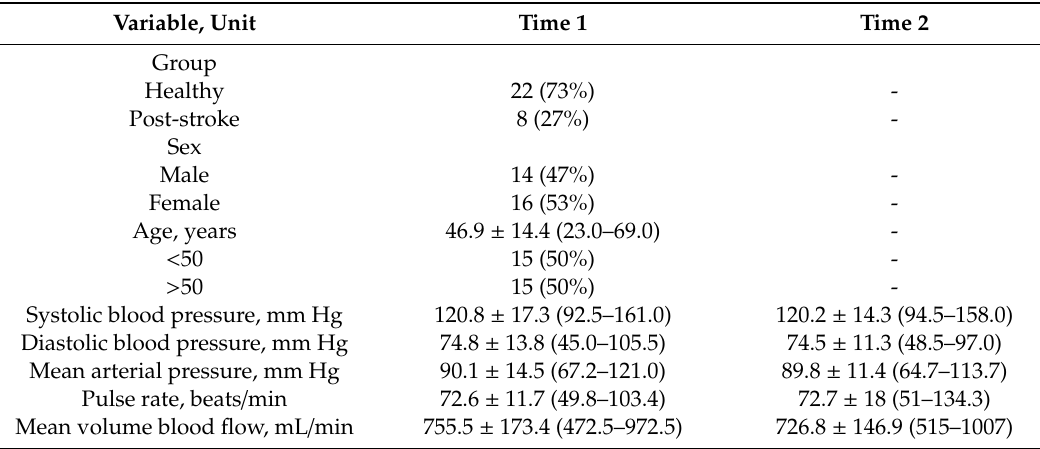
Table 1. Population